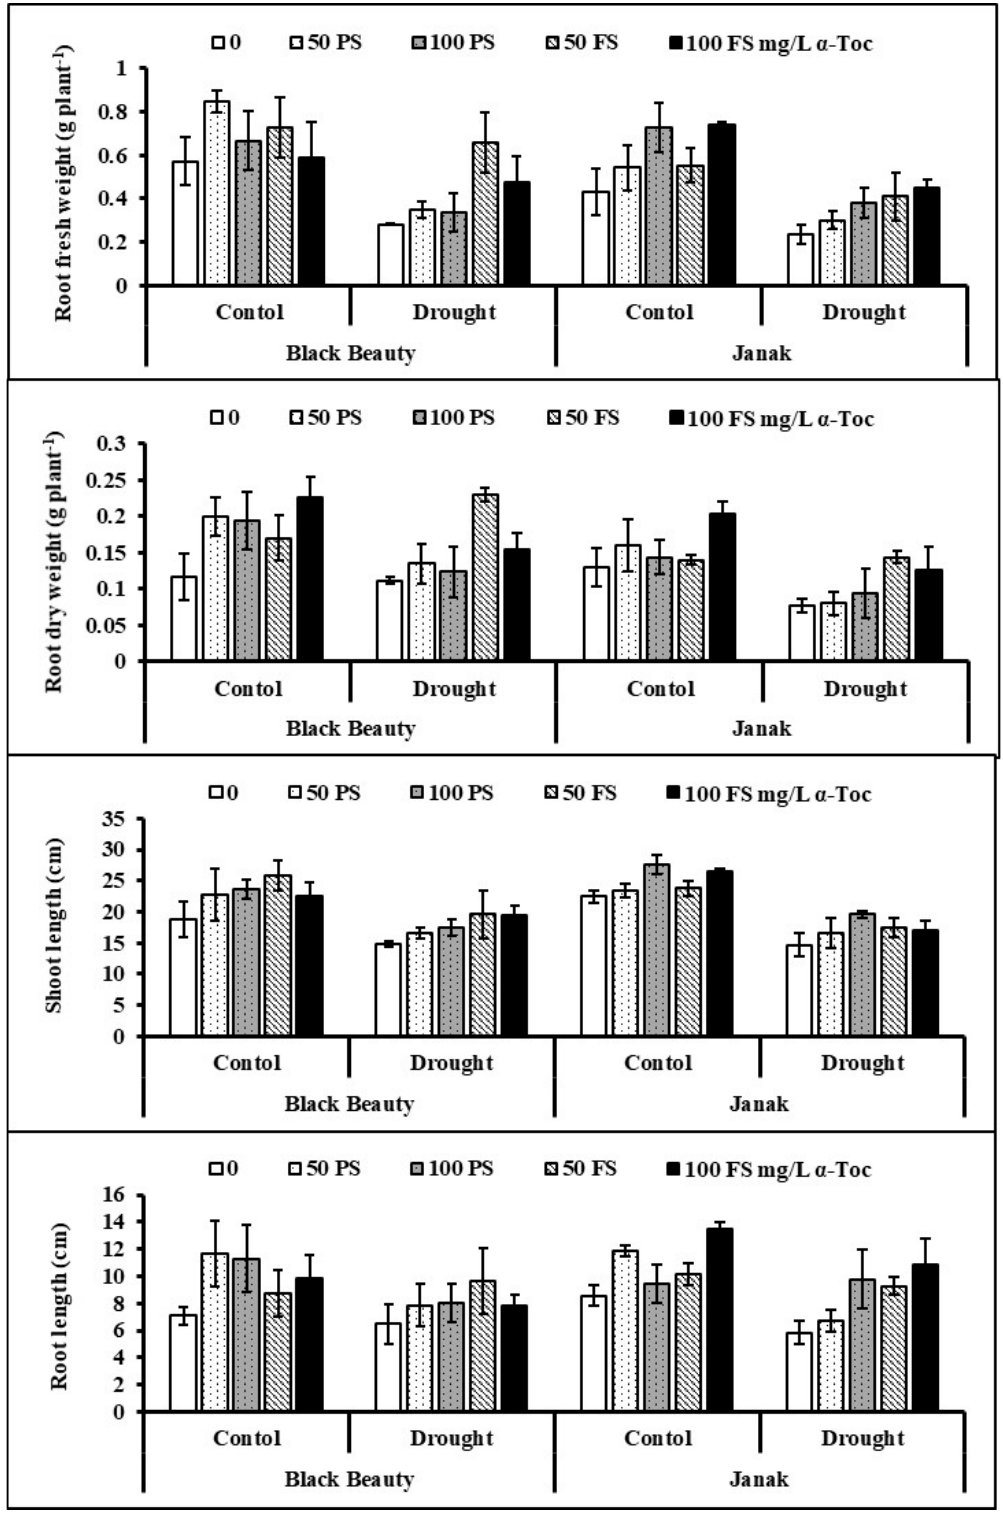
Figure 1. Fresh root weights, dry root weights, and lengths of eggplants subjected to exogenous TOC (pre-sowing (PS) and foliar spray (FS)) under varying water regimes (mean ± S.E.; n = 4).